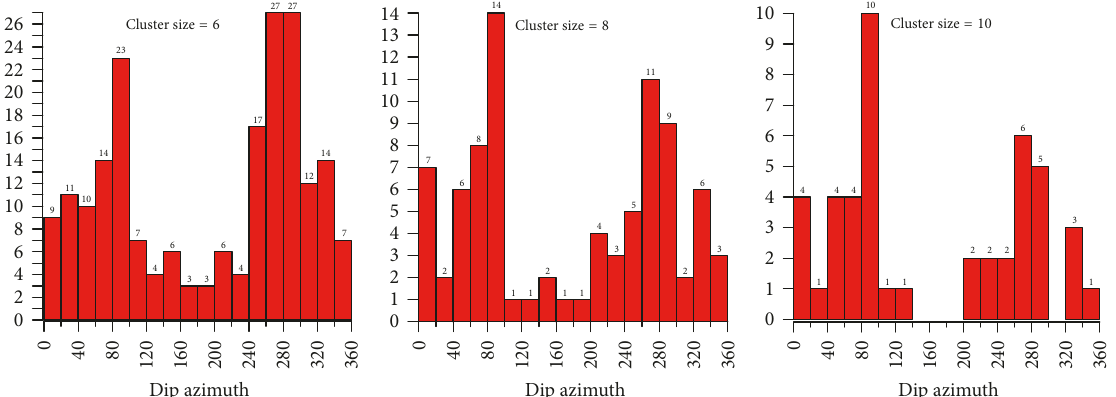
Figure 33: Histograms of the Frac-Digger sensitivity of the estimated dip azimuths of dikes to the cluster size (or the number of events in cluster 𝑁